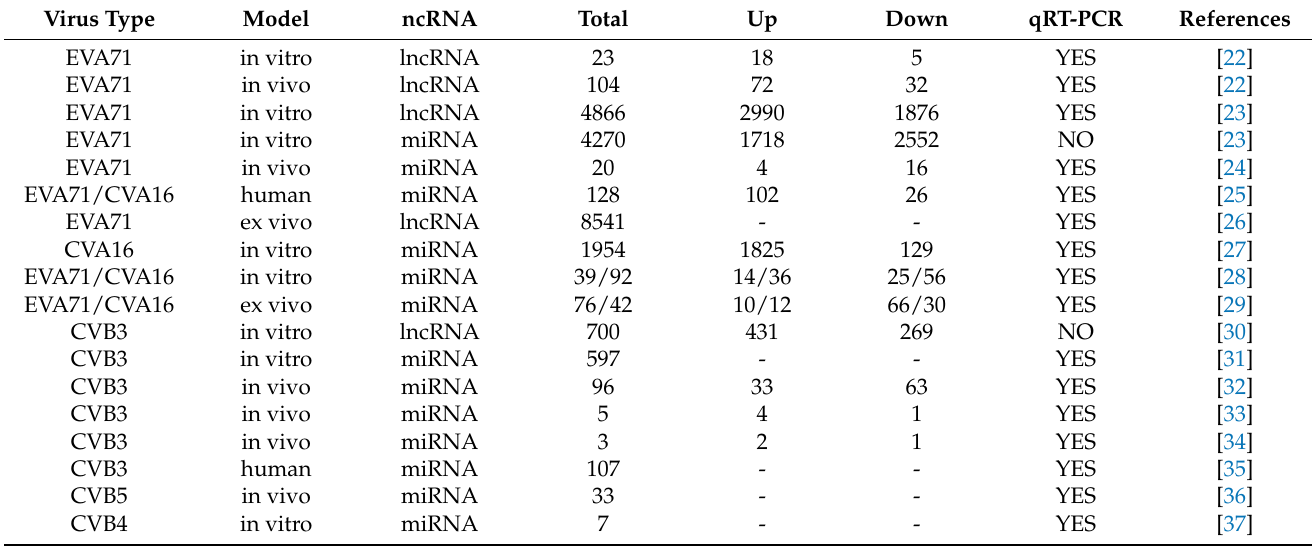
Table 2. The aberrant expression profile of non-coding RNAs (ncRNAs) in host cells induced by EVs. Virus